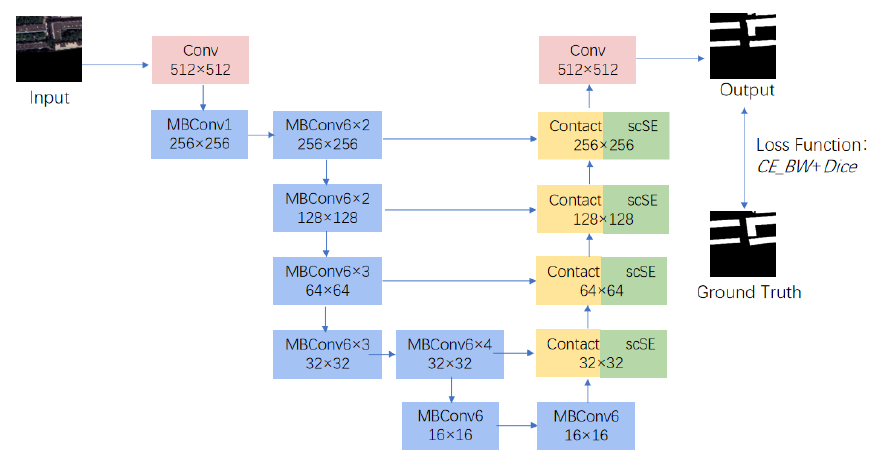
Figure 2. EfficientUNet+ module structure.